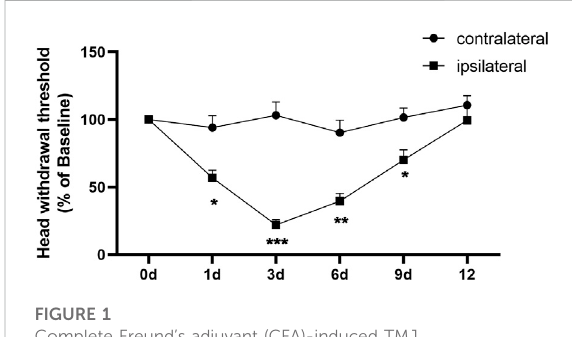
FIGURE 1 Complete Freund ’ s adjuvant (CFA)-induced TMJ in fl ammation. Unilateral injection of CFA robustly decreased head withdrawal threshold in ipsilateral side of trigeminal nerve branch- innervated facial skin area. n = 9 mice/group. * p < 0.05, ** p < 0.01, and *** p < 0.001 versus the corresponding contralateral side using two-way